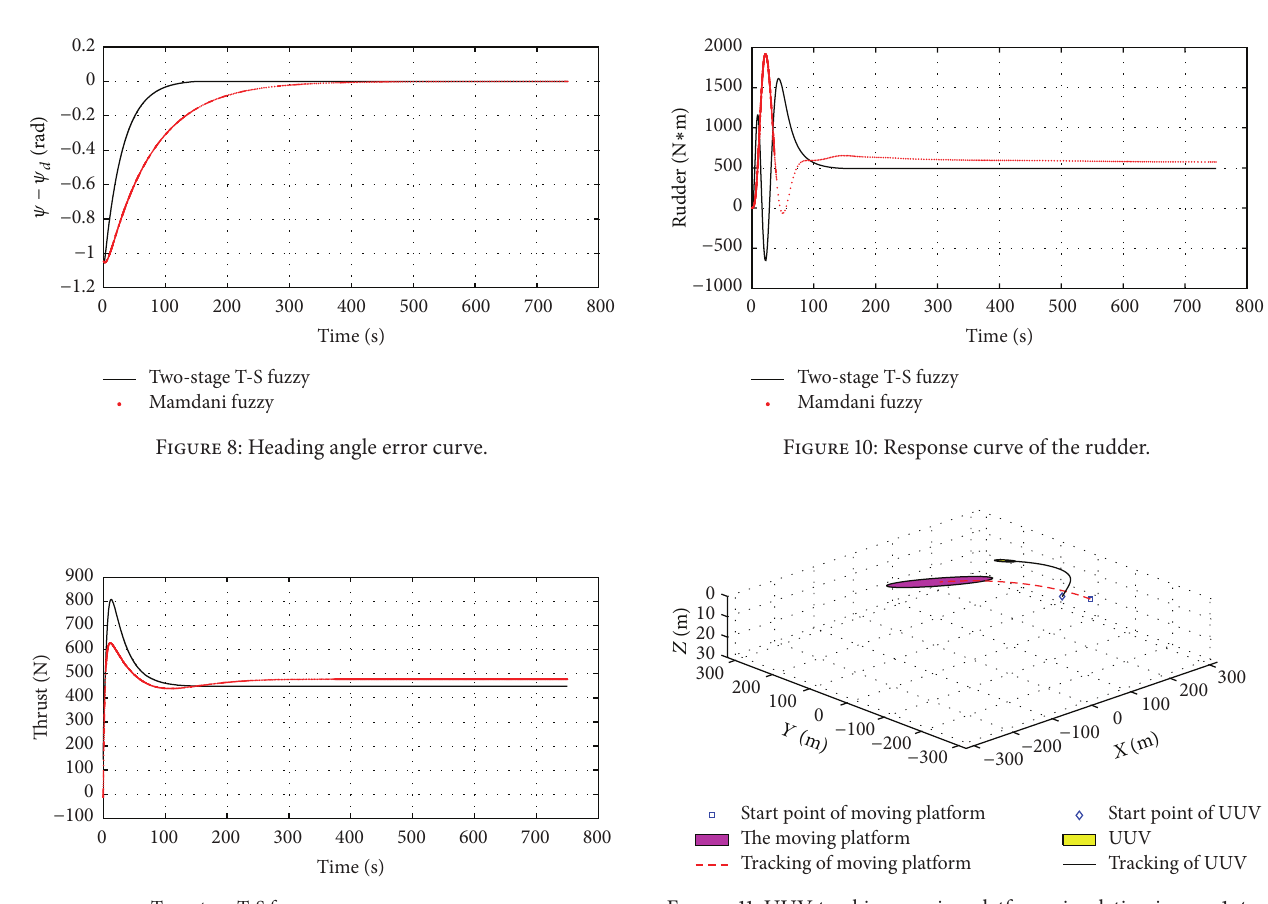
Figure 11: UUV tracking moving platform simulation in case 1: 𝑡 = 100 s.